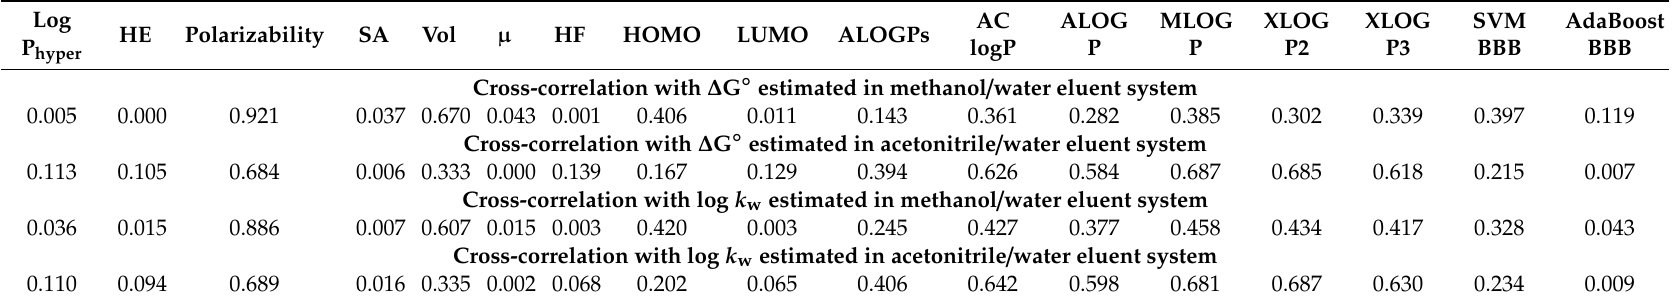
Table 4. Cross-correlations of ∆ G ◦ and log k w estimated in methanol and acetonitrile eluent system with the theoretical